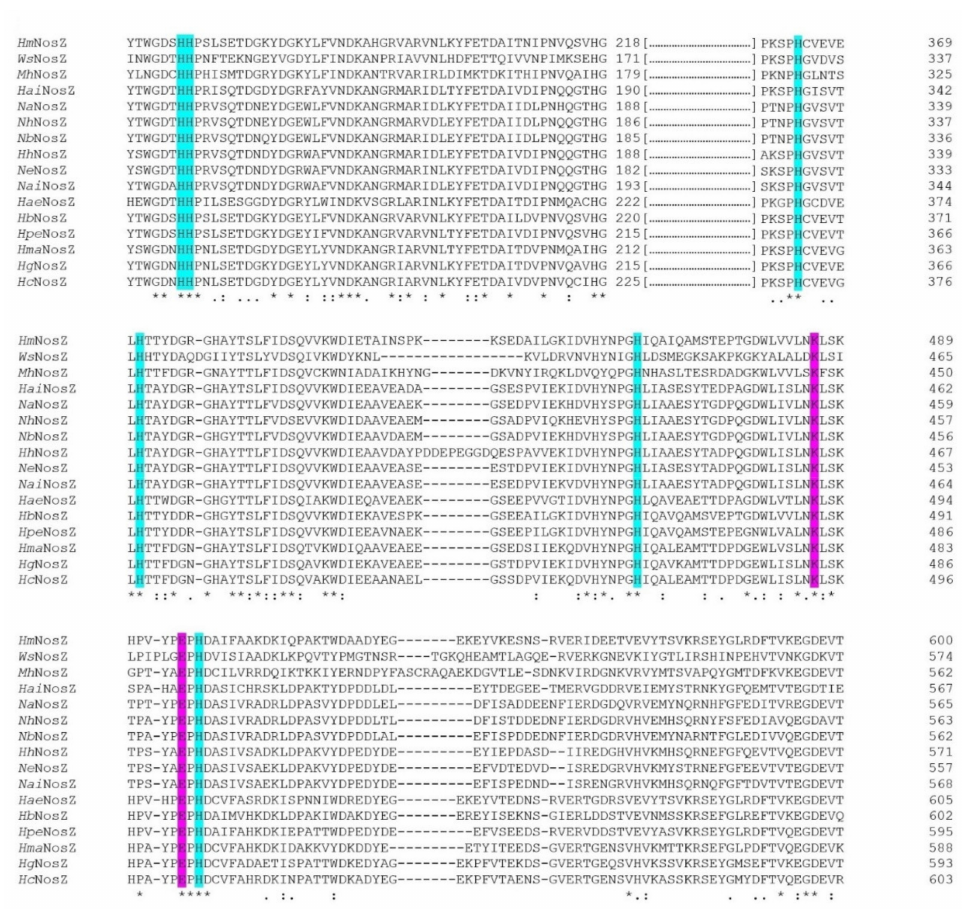
Figure 9. Clustal omega alignment of the Cu A centre coordination region from Wolinella succinogenes ( Ws NosZ; Protein